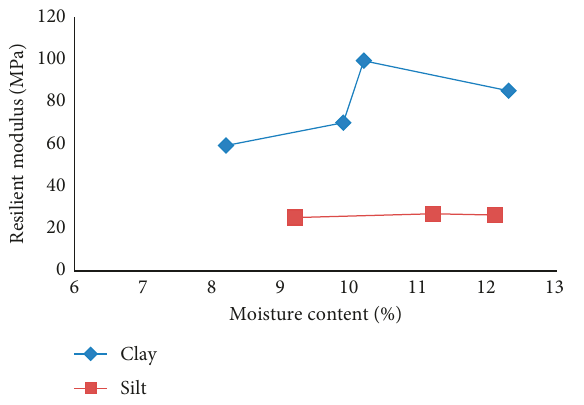
Figure 3: Resilient modulus of subgrade in different moisture